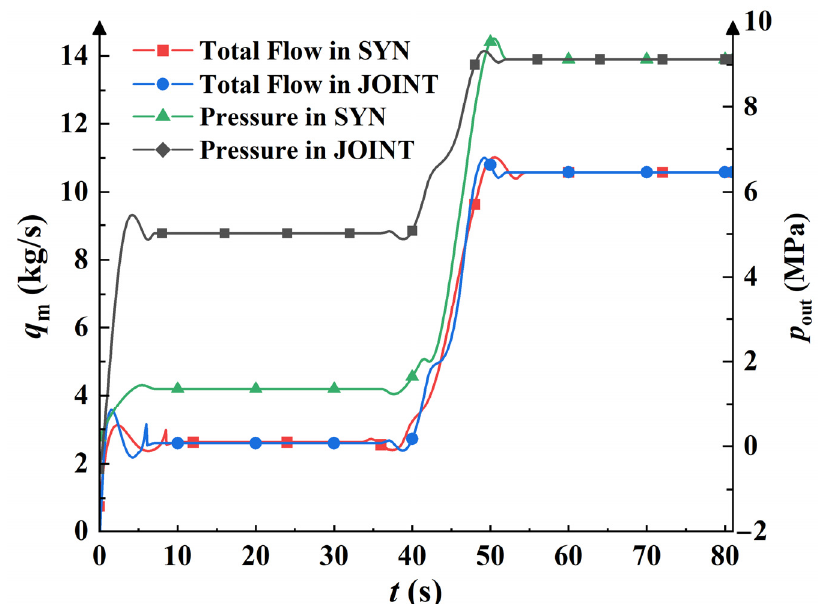
Figure 20. Comparison of flow and outlet pressure of pump in Scheme SYNC vs. Scheme JOINT.